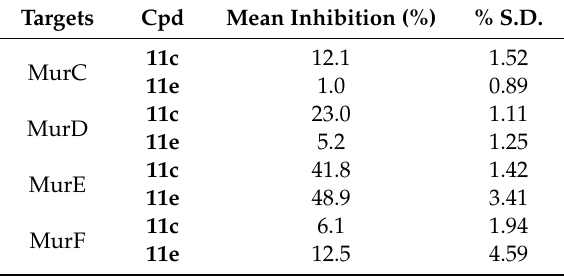
Table 3. Inhibitory e ff ect of compound 11c and 11e (100 µ M) on Mtb MurC-F ligases. Targets Cpd Mean Inhibition